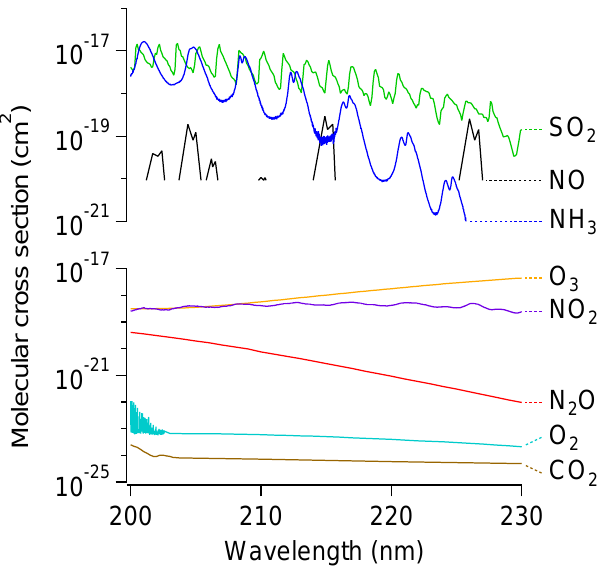
Fig. 1. Upper graph: absorption by NH 3 ( T =295K; Chen et al., 1999), NO ( T =298K; spectrum only partly available; Thompson et al., 1963), and SO 2 ( T =293K; Manatt and Lane, 1993). Lower graph: CO 2 ( T =298K; Shemansky, 1972), NO 2 ( T =293K; Jenouvrier et al., 1996), O 3 ( T =298K; Molina and Molina, 1986), O 2 Schumann-Runge bands ( T =300K; Yoshino et al., 1992), and O 2 Herzberg continuum ( T =298K; Cheung et al., 1986), and N 2 O ( T =301K; Selwyn et al., 1977).